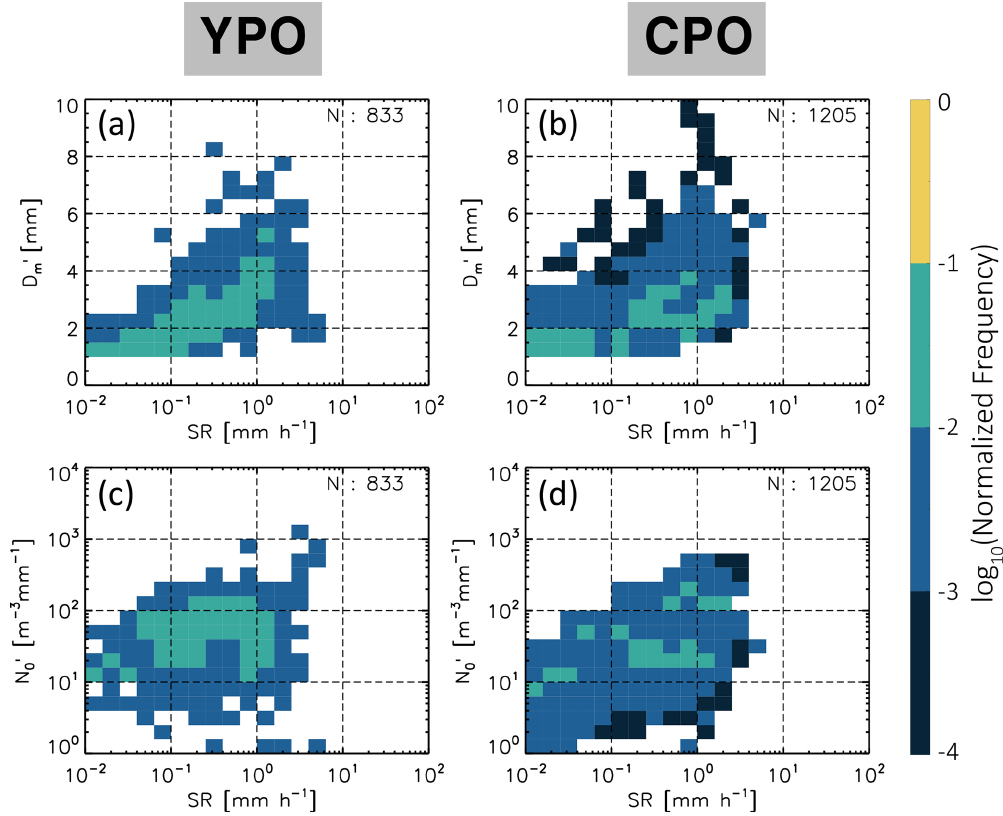
Figure 10. Normalized frequency of D (cid:48) m –SR (a, b) and N (cid:48)